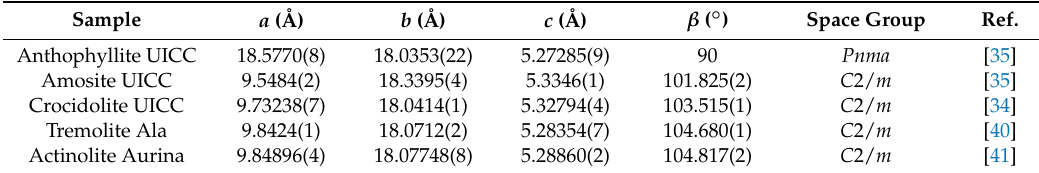
Table 2. XRD data for the studied reference amphiboles.